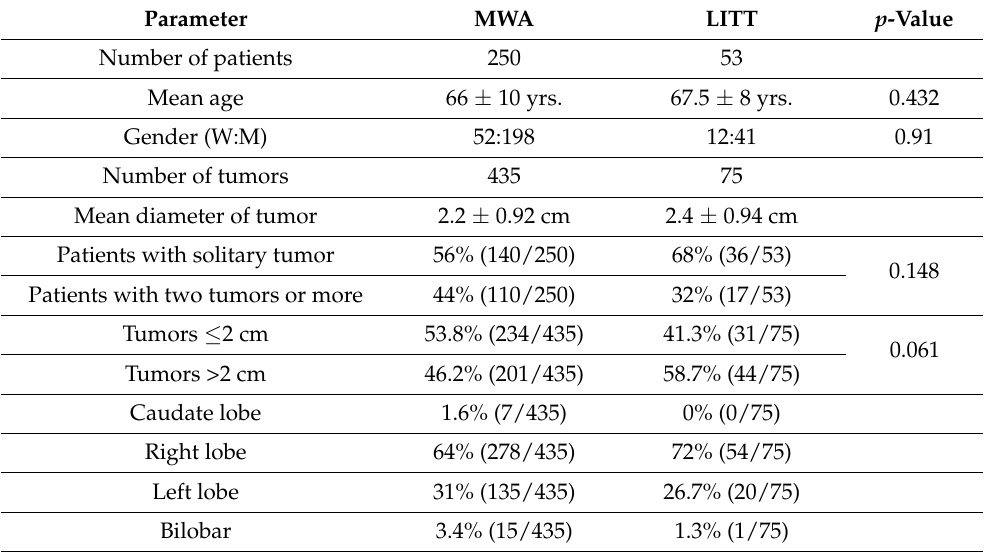
Table 1. Characteristics of patients and